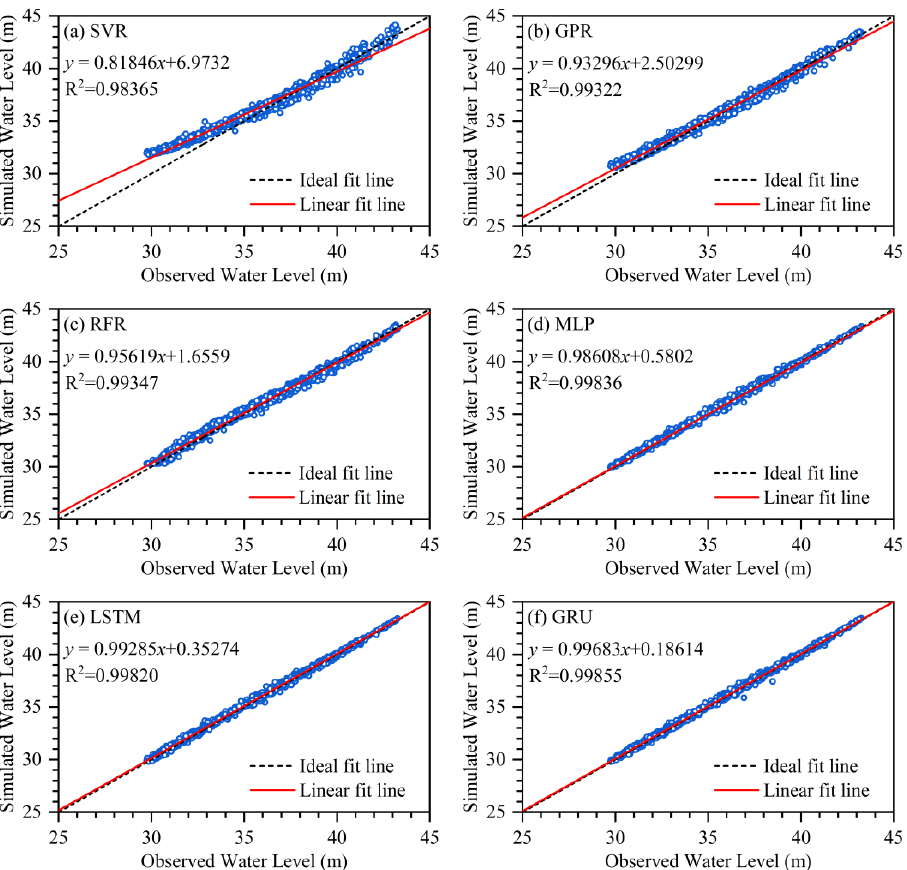
Figure 8. Scatter plots of the simulated and observed water levels of Shashi Station by different ML models during the testing period.